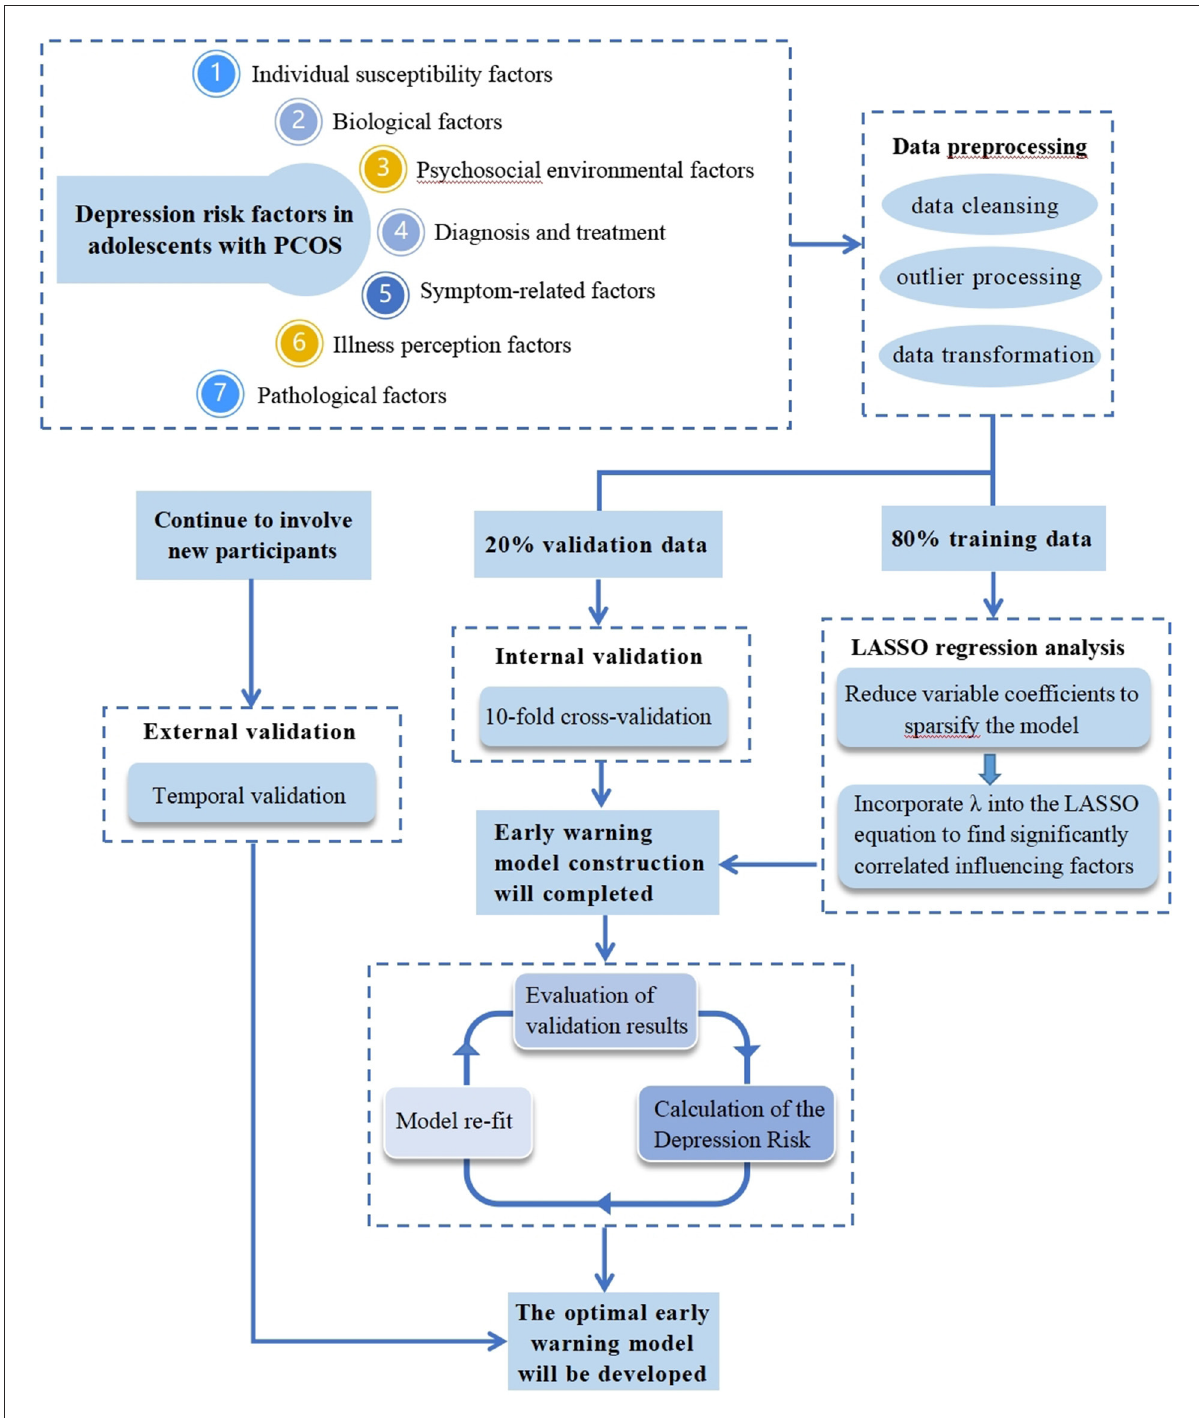
FIGURE2 Simulation diagram for developing and validating a LASSO-based model to predict depression in adolescents with PCOS.